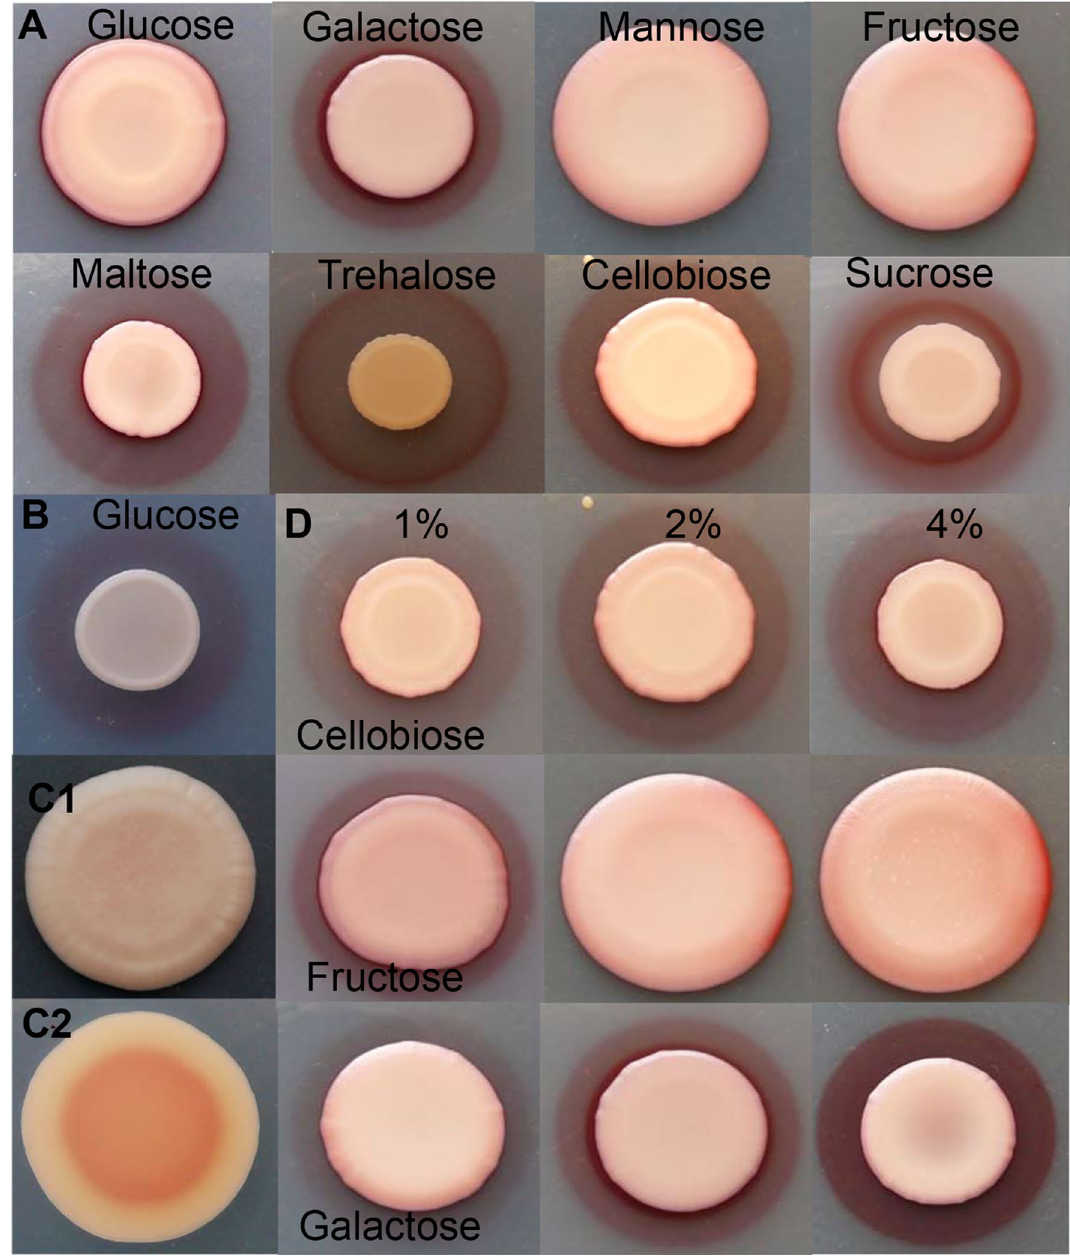
Figure 2. Pigment production can depend on the type and concentration of sugar. SMA contained 2% sugar and 0.001 mg/ml FeCl 3 and was photographed after 13 days ( A ) and 3 days ( B ). M. chrysoperlae produced a small amount of red pigment on 2% maltose containing SMA ( C1,2 ). Top side ( C1 ) and bottom side ( C2 ) of the colony (almost similar results were found on 2 and 4% glucose, sorbose, fructose-containing SMA, 4% sucrose, galactose containing SMA). Pigment production on 1, 2, 4% sugar-containing media (photographed after 13 days) ( D ). (Glucose, maltose, trehalose-containing media were similar to the cellobiose containing media). Mannose-containing medium was similar to the fructose containing media, while sucrose containing medium was similar to the galactose containing medium). Agar plates were incubated at 25 pigmented zone at all temperatures, compared to the control (0% pectin). In contrast, the higher agar concen- tration (2.5%) reduced the size of the halo (Fig. 3B), but did not influence the colour intensity of the pigment (Fig. 3C1). Similar results were obtained in the case of the M. pulcherrima strains used as a control (Fig. 3C2). M. chrysoperlae, which was regarded as a non-pigment producing species 32 and was used as a negative control in these experiments (Fig. 3C3), was also able to produce a small amount of pigment, especially on medium containing 2 or 4% maltose (Fig. 2C1). However, pink cells could be found mainly on the bottom side of the